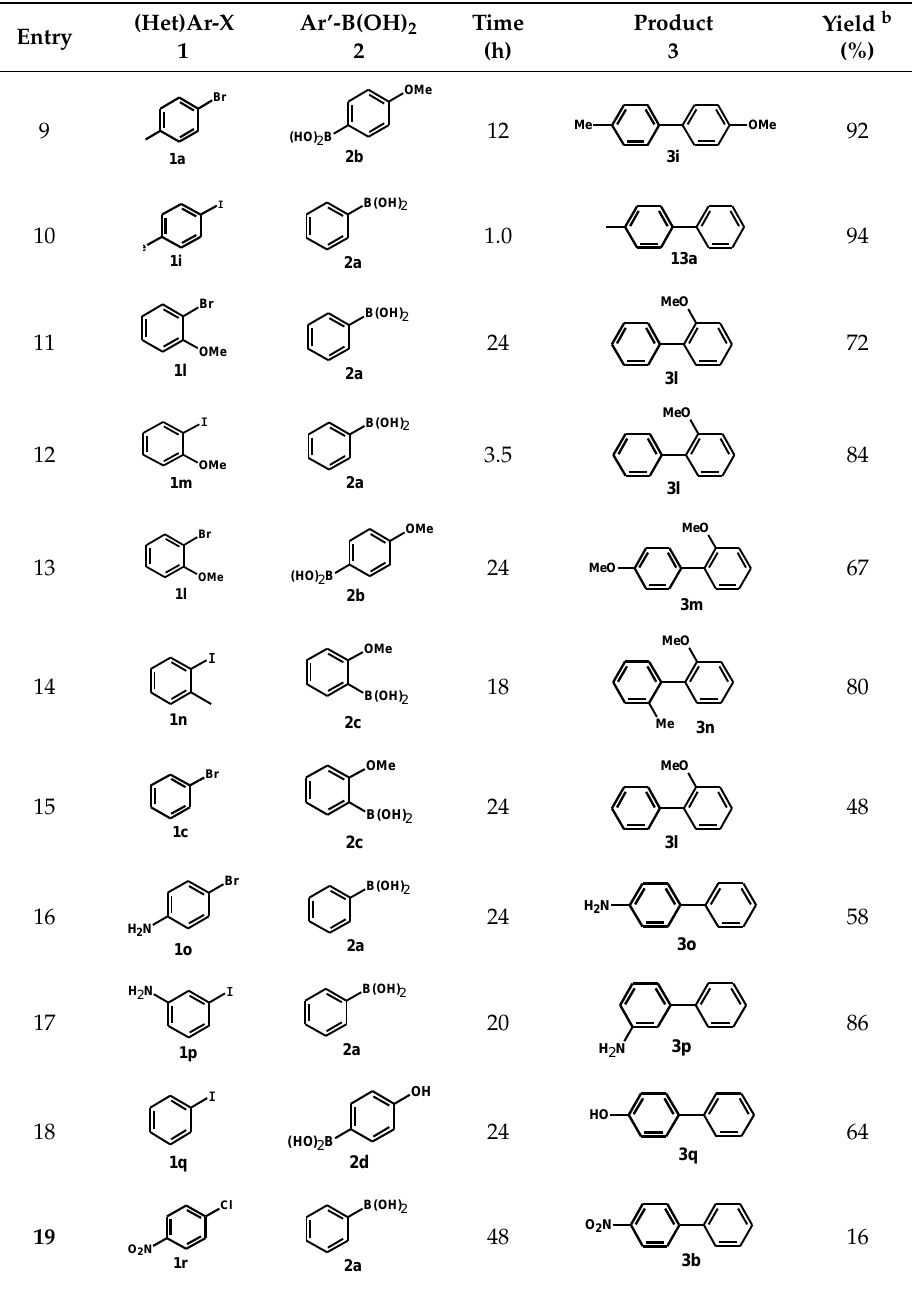
a Reaction conditions: 2.00 mmol of 1 , 2.50 mmol of 2 , K 3 PO 4 (6 mmol), Pd/PVPy (0.15 mol % of Pd), 4.0 mL DMA/H 2 O (4:1), T = 125 °C. b Isolated yield evaluated by medium pressure liquid chromatography purification on silica gel.